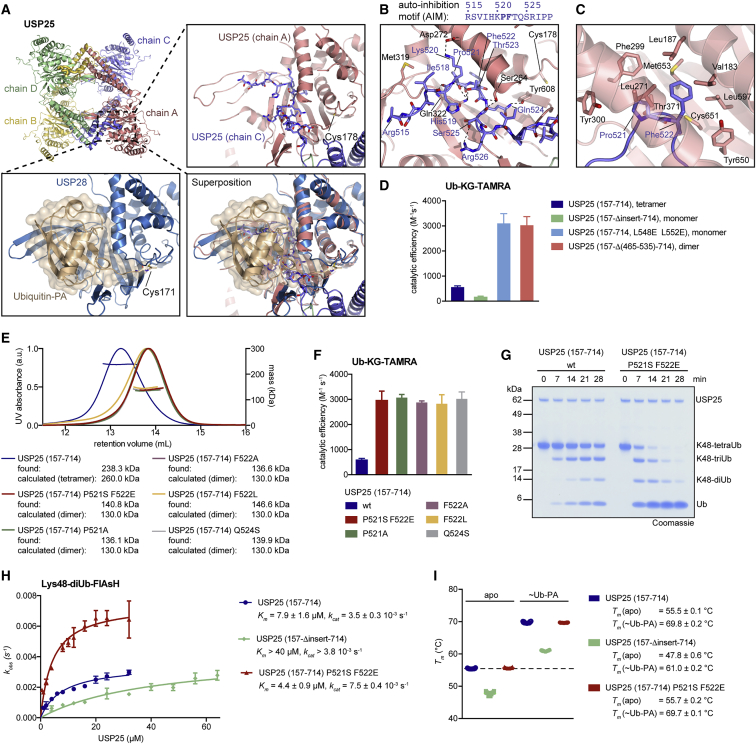
Tetramerization of USP25 Mediates Autoinhibition In trans through a Conserved AIM within the Domain Insertion(A) Top left: cartoon representation of the tetrameric catalytic domain of USP25. The area shown as close up is indicated. Top right: close-up view of chain A with the AIM of chain C shown as sticks is shown. Bottom left: USP28 (149-Δinsert-703) bound to Ub-PA under a semitransparent surface is shown. Bottom right: Superposition of the close ups shows the mutually exclusive binding of the AIM and ubiquitin. The catalytic cysteines Cys171 (USP25) and Cys178 (USP25) are shown for orientation.(B) Detailed view of the interaction between AIM and ubiquitin-binding site of USP25. Dashed lines indicate polar interactions.(C) A hydrophobic pocket in the USP25 catalytic domain accommodates Pro521 and Phe522 of the AIM.(D) Catalytic activities of USP25 constructs determined from Ub-KG-TAMRA cleavage assays by fluorescence anisotropy measurements. Data are shown as mean ± SE from 5 independent experiments. See Figure S4G for anisotropy time courses.(E) SEC-MALS analysis of indicated USP25 proteins. Identified masses are matched to either tetrameric or dimeric expected masses.(F) Catalytic activities of USP25 constructs analyzed in (E), determined from Ub-KG-TAMRA cleavage assays by fluorescence anisotropy measurements. Data are shown as mean ± SE from 3 independent experiments. See Figure S4H for anisotropy time courses.(G) Time course analysis of Lys48-linked tetraUb cleavage. The assay was performed three times with consistent results.(H) Catalytic activities of USP25 constructs determined from Lys48-diUb-FlAsH cleavage assays. Data are shown as mean ± SE from 3 independent experiments performed in technical triplicates. Kinetic parameters obtained from fitted curves are listed.(I) Protein melting temperatures from thermal shift assays of indicated samples. Individual data points are plotted (n = 10), and melting temperatures are listed as mean ± SD.